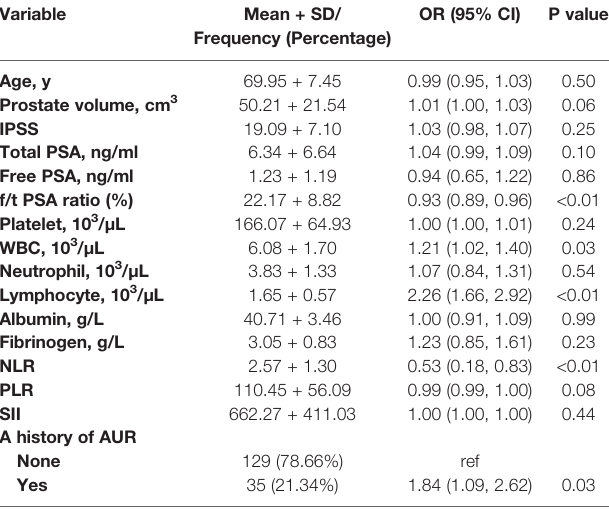
TABLE 2 | Univariate analysis on the associations of clinical and laboratory parameters with moderate to severe prostatic in fl ammation. Variable